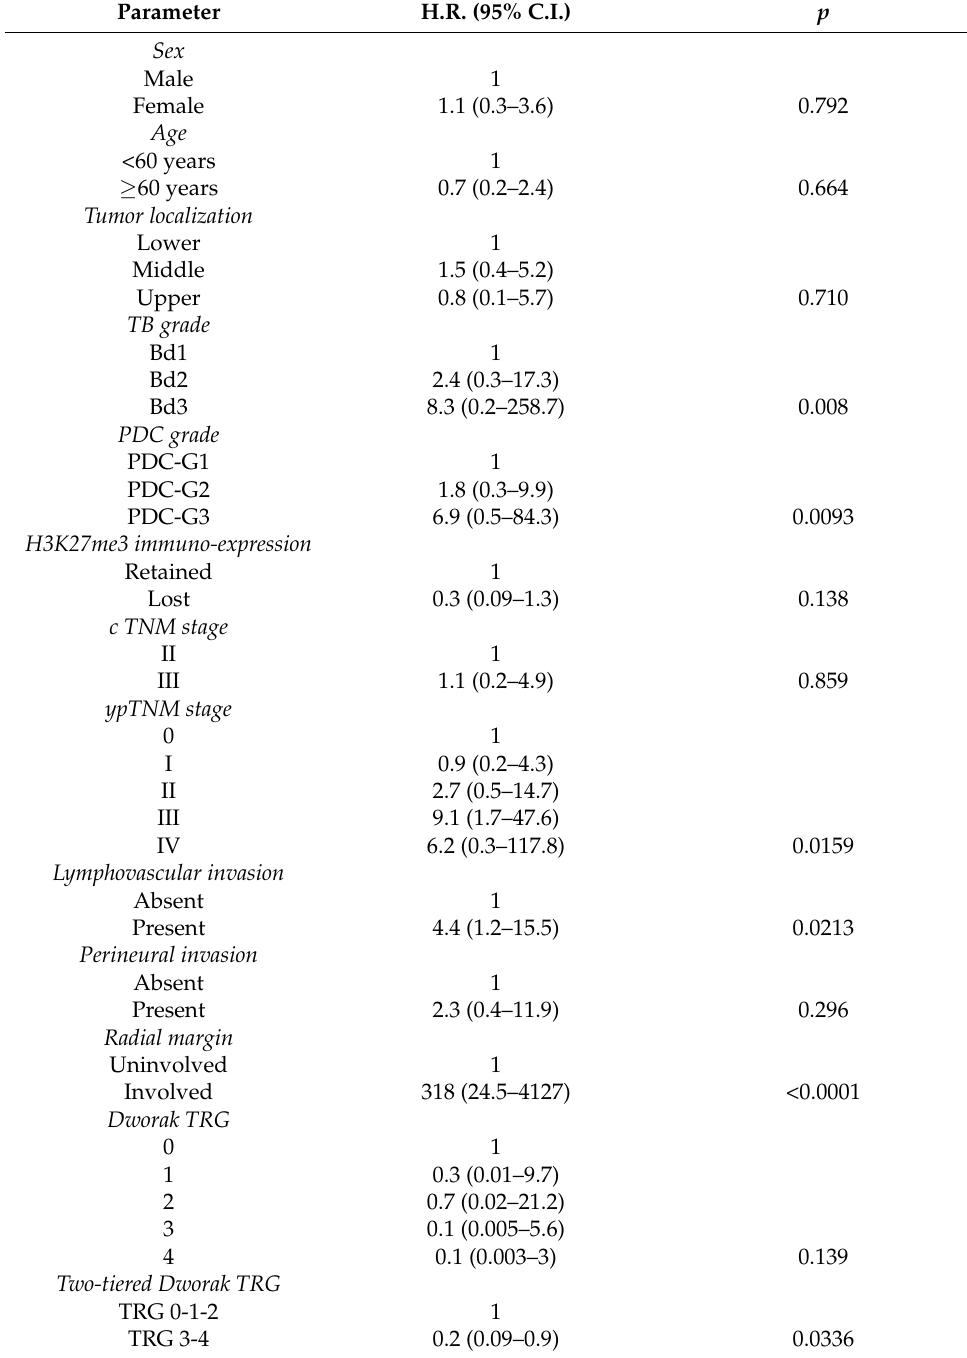
Table 3. Univariate analyses for PFS in 46 patients with rectal adenocarcinomas treated with neoadju- vant chemo-radiotherapy and